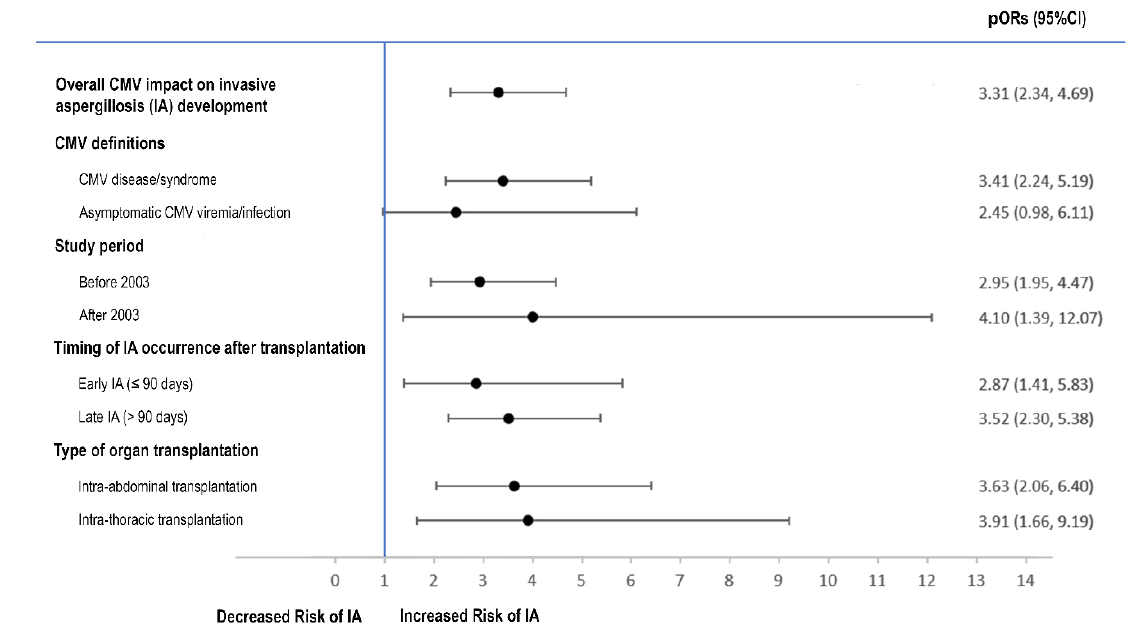
Figure 3. Subgroup analyses on the impact of CMV on post-transplant IA. CI: confidence interval; CMV: cytomegalovirus; IA: invasive aspergillosis; pOR: pooled odds ratio.